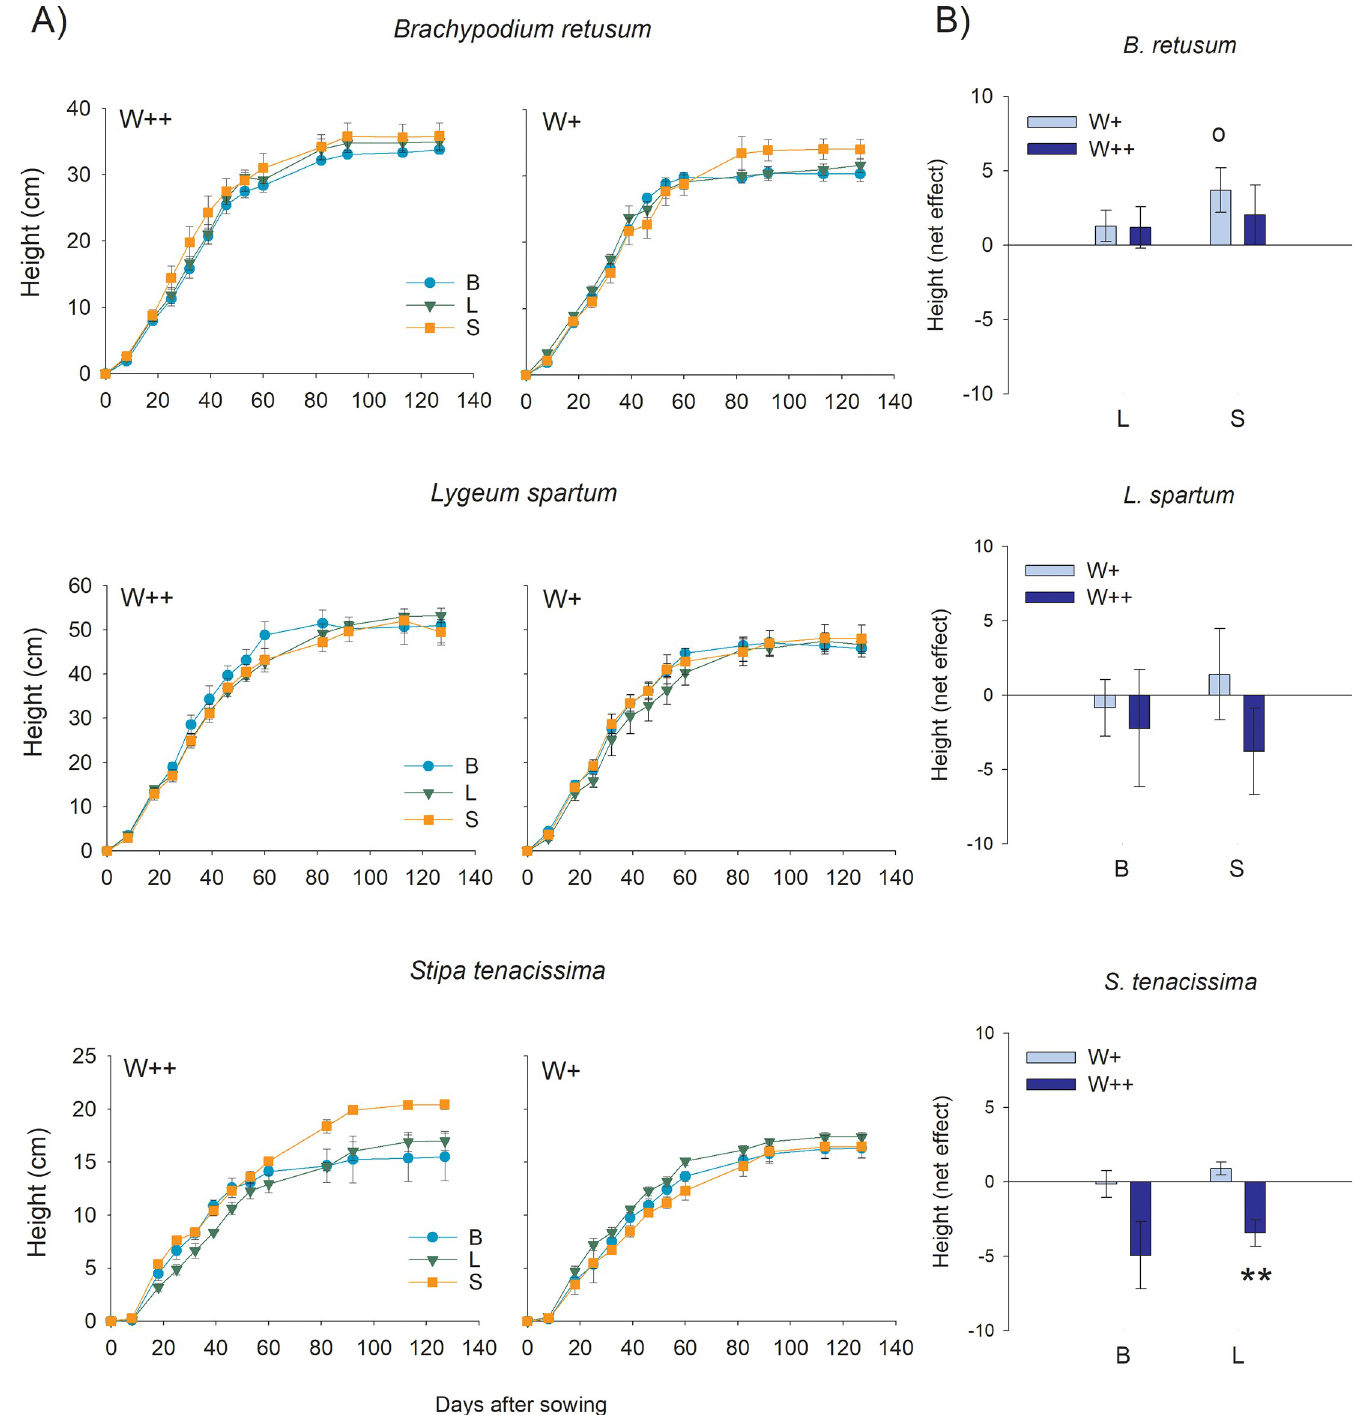
Fig 1. Pairwise interaction effect on plant height. A) Average ( ± 1 SE) height for the three target species as a function of the accompanying species: B ( B . retusum , light blue circles); L (L . spartum , green triangles); S ( S . tenacissima , orange squares) and the watering regime applied (W++, frequent watering; W+, reduced watering). B) Difference (net effect) in final plant height at the end of the study period (140 days) between each bi-specific culture and the average of the respective monospecific cultures for each target species. Asterisks and empty circles represent, respectively, significant and marginally significant deviations of net effects from zero (two-tailed Student’s one-sample t-tests): p < 0.01 ( �� ), and p < 0.06 (˚); n = 4. Note the change in Y axis scaling.